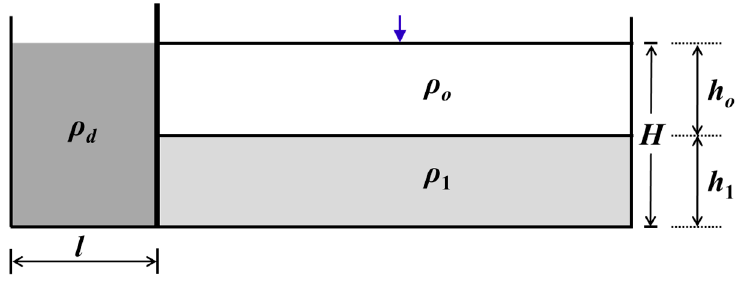
Figure 10. Sketch and parameters for the intrusive gravity current cases.